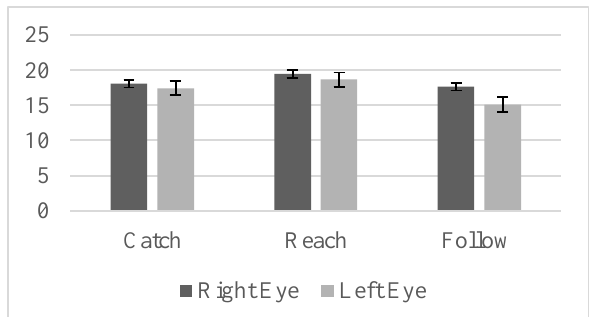
Figure 6. Left- and Right-Eye Pupil Size Differences under Right-Hand Condition for